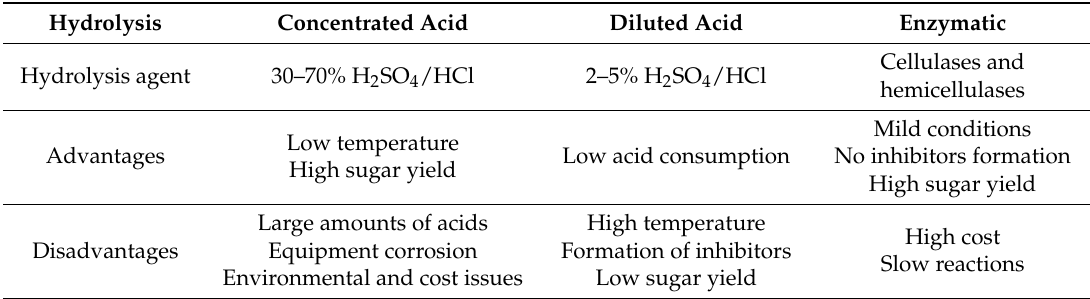
Table 2. Hydrolysis agents, advantages and disadvantages of different types of